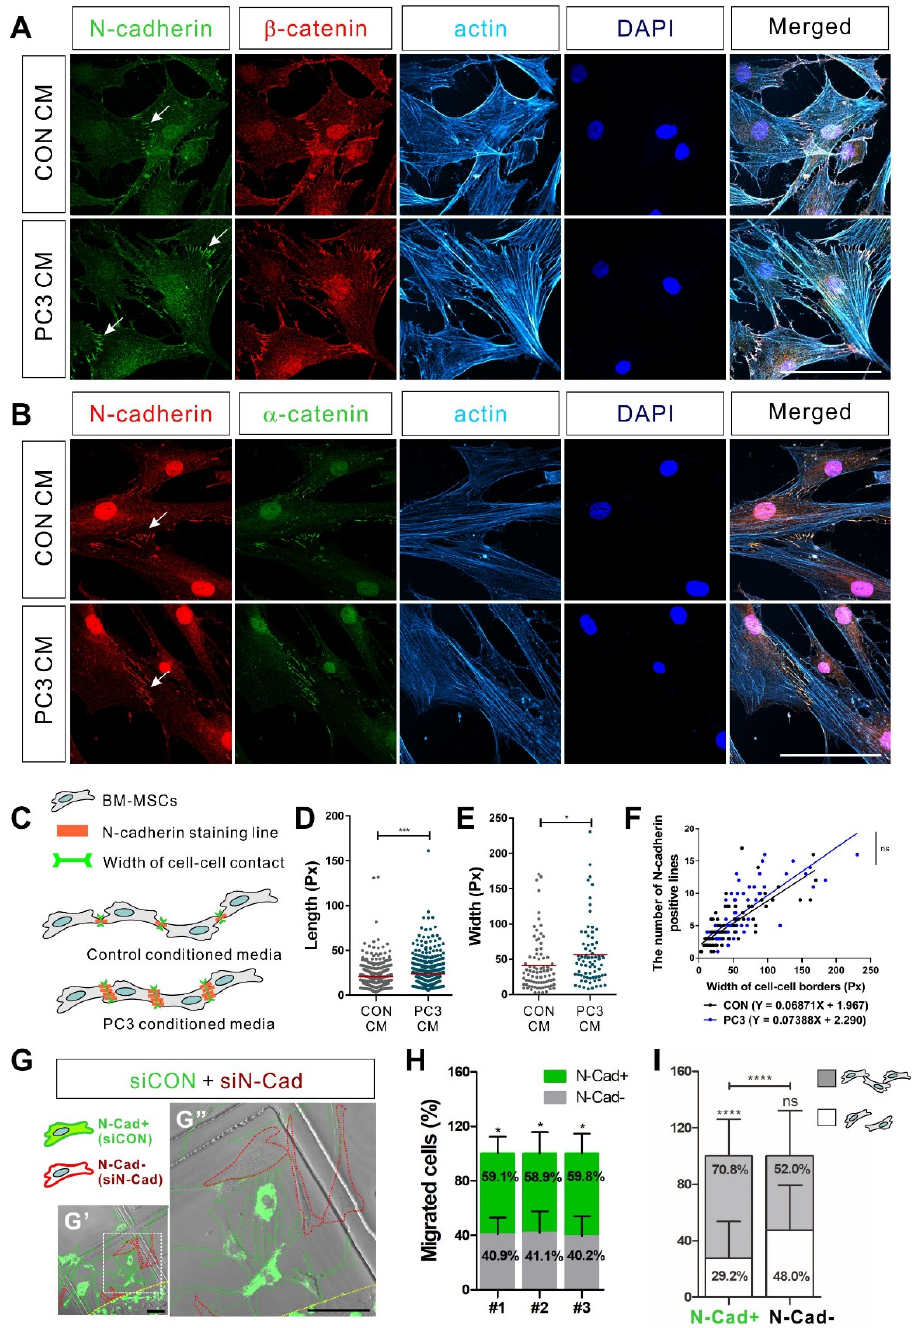
Figure 6. N-cadherin-mediated cell–cell adhesion is required for the migration of bone marrow-derived mesenchymal stem cells (BM-MSCs) toward the PC3-conditioned medium. ( A , B ) Immunocytochemistry of N-cadherin, β -catenin, and ɑ -catenin in BM-MSCs treated with the control-conditioned medium (CON CM) or the PC3-conditioned medium (PC3 CM). N-cadherin was stained in green and β -catenin was stained in red ( A ). N-cadherin was stained in red and ɑ -catenin was stained in green ( B ). Actin was stained with phalloidin in sky blue and nuclei were stained with DAPI in blue. White arrows indicate colocalization of N-cadherin and β -catenin or colocalization of N-cadherin and ɑ -catenin at cell–cell adhesion borders. Scale bars indicate 100 µm. ( C ) Schematic representation of measuring the number of N-cadherin positive lines at cell–cell junction-like structures and the width of cell–cell contact composed of N-cadherin positive lines. ( D ) Quantification of the length of N-cadherin positive lines on cell–cell junction-like structures of BM-MSCs treated with CON CM or PC3 CM for 24 h. The red lines indicate the mean values ( n = 4 samples for each group; Px, pixel). ( E ) Quantification of the width of cell–cell contact composed of N-cadherin positive